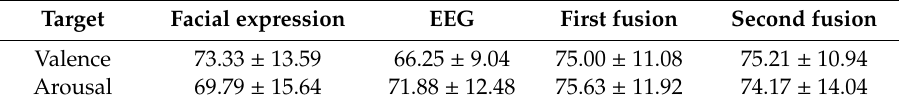
Table 1. Emotion recognition accuracy for the MAHNOB-HCI data set.